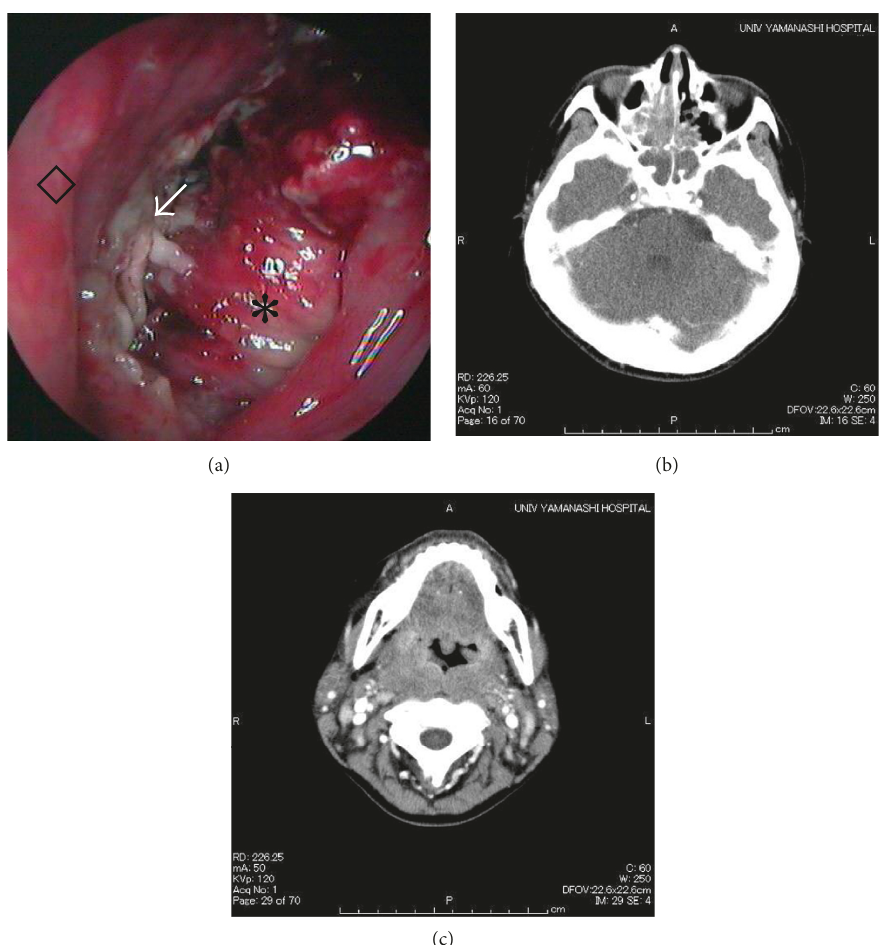
Figure 1: Scope image and computed tomography (CT) findings. (a) Scope image of the left nasal cavity. White granulation tissue is observed (arrow). ∗ : inferior turbinate and ◇ : nasal septum. (b) Axial CT with contrast demonstrating soft tissue lesions or effusions in the ethmoid and sphenoid sinuses. (c) Axial CT with contrast demonstrating mucosal and tissue swelling in the